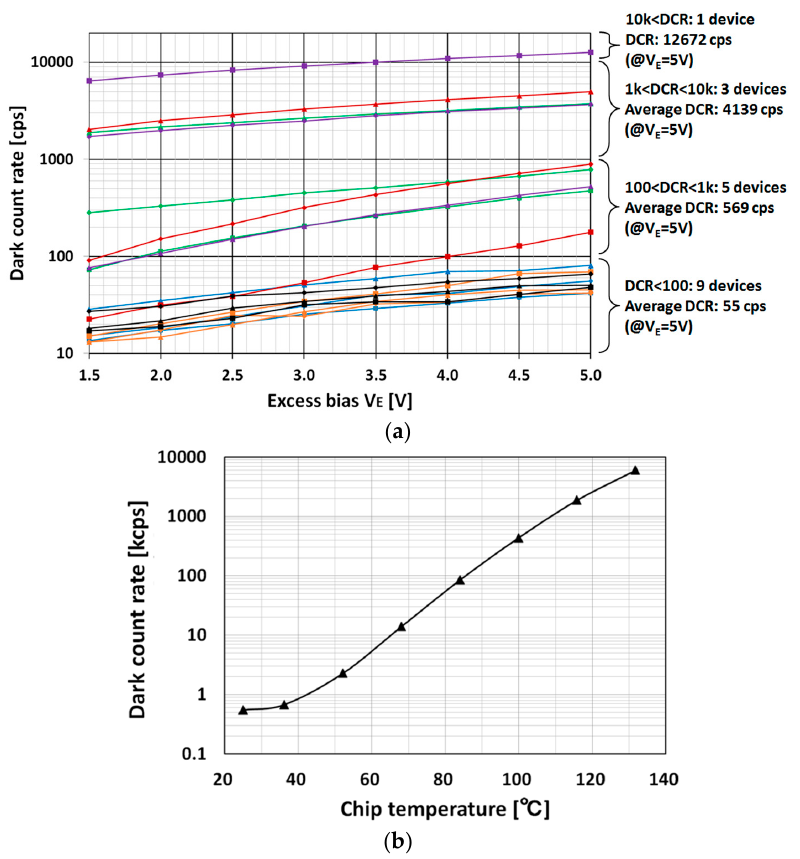
Figure 7. ( a ) Measurement results of DCR as a function of excess bias V E , using 18 SPAD samples in 6 test chips at room temperature; ( b ) Measurement results of DCR as a function of chip temperature, using one SPAD sample.